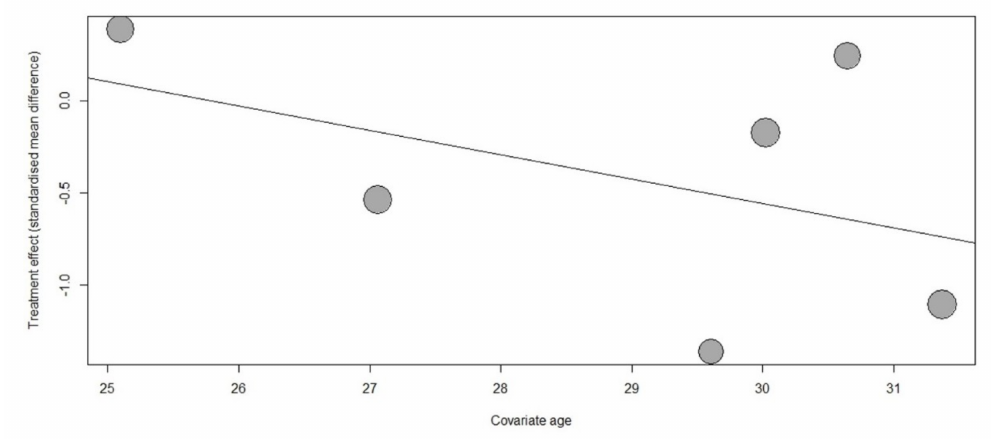
Figure 4. Meta-regression bubble plot of correlation between standardized mean di ff erence of anxiety scores and age. Each bubble represents a study and bubble size represents the sample size of the study. The regression line shows a nonsignificant trend for the increased anxiolytic e ff ect of music interventions with increasing maternal age ( p =